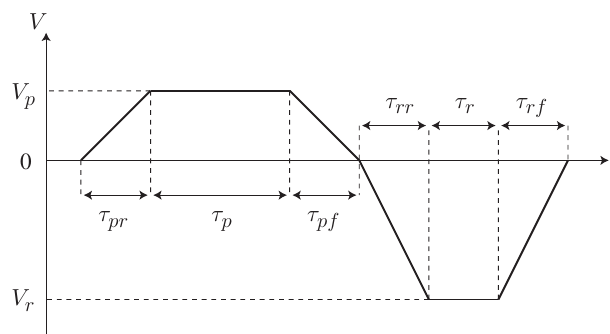
FIG. 7. Typical induction-voltage waveform. The waveform consists of main and reset pulses.